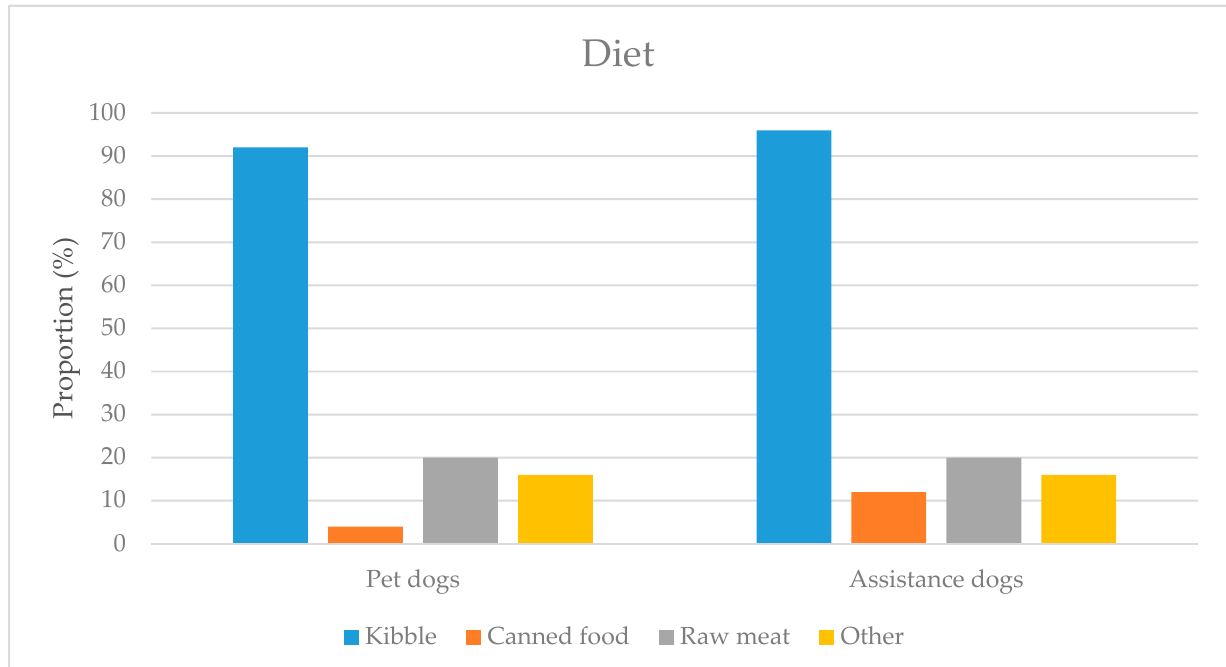
Figure 4. The diets of pet dogs and assistance dogs.